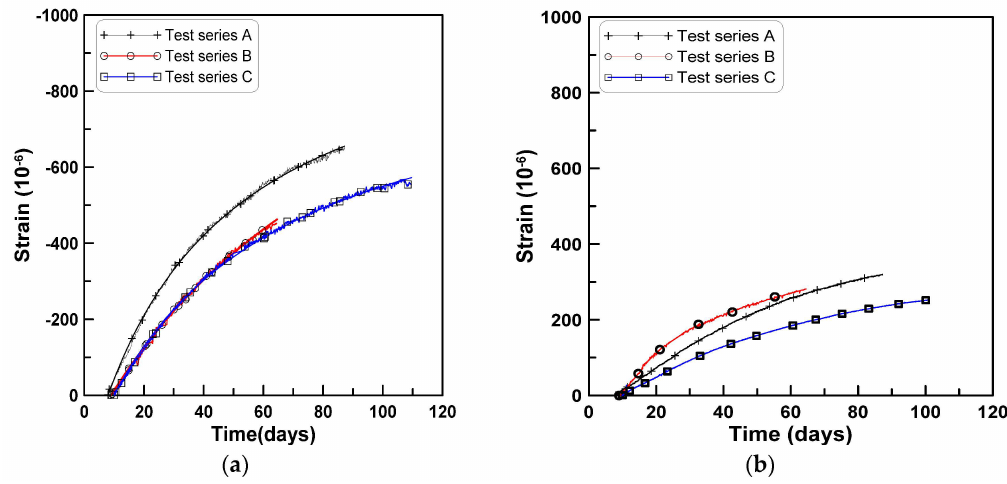
Figure 11. Uniform and skewed parts of shrinkage strains for four test series: ( a ) Uniform part strain; ( b ) skewed part strain.